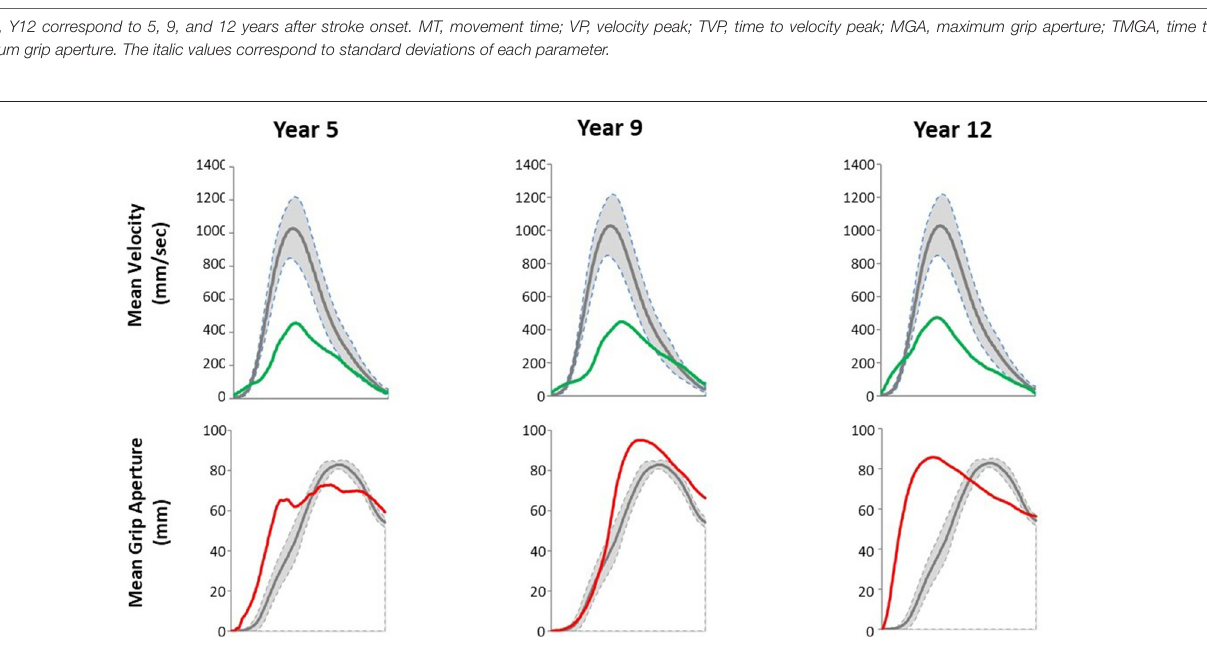
Frontiers in Neurology |